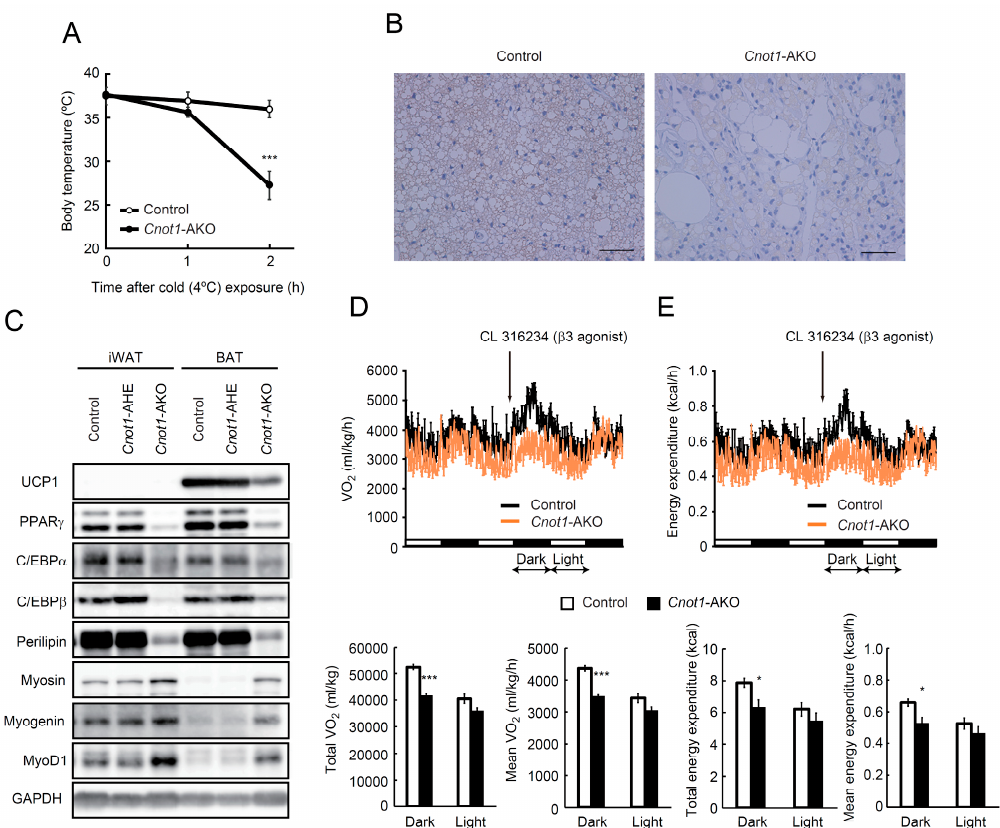
Figure 3. Cnot1 -AKO mice show cold intolerance. ( A ) Cold tolerance test in 20-week-old control ( n = 5) and Cnot1 -AKO ( n = 4) mice, individually housed at 4 ◦ C for 2 h. The core body temperature was monitored every hour with a thermometer. ( B ) Immunohistochemistry for UCP1 in BAT of control and Cnot1 -AKO mice. Scale bars, 50 µ m. ( C ) Immunoblot analyses of the indicated proteins in BAT of control, Cnot1 -AHE, and Cnot1 -AKO mice. Cnot1 -AHE indicates mice with the genotype Cnot1 +/ loxP : Adiponectin-cre . ( D , E ) Oxygen consumption ( D ) and energy expenditure ( E ) in 20-week-old mice were measured. Mice were injected intraperitoneally with CL316243 at the indicated time points (arrows) ( n = 3). Both the total and the mean oxygen consumption and energy expenditure were calculated separately for dark and light periods after β 3-agonist injection (12 h each, double arrows), and are shown in bar plots. Values in the graphs represent mean ± sem. * p < 0.05, *** p < 0.001, unpaired t-test.